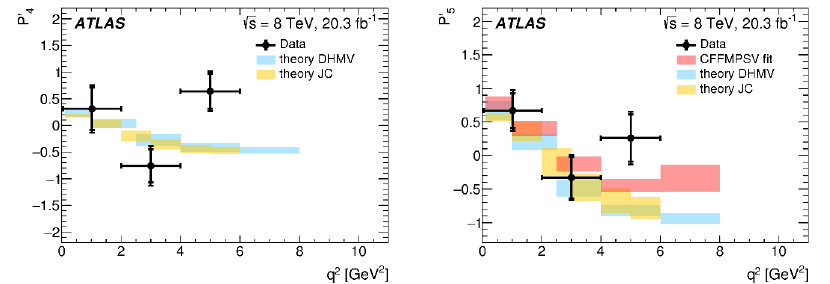
Figure 4: The measured values of P (cid:48) (left) and P (cid:48) (right) compared with predictions from 4 5 the theoretical calculations. Statistical and total uncertainties are shown for the data, i.e. the inner mark indicates the statistical uncertainty and the total error bar the total